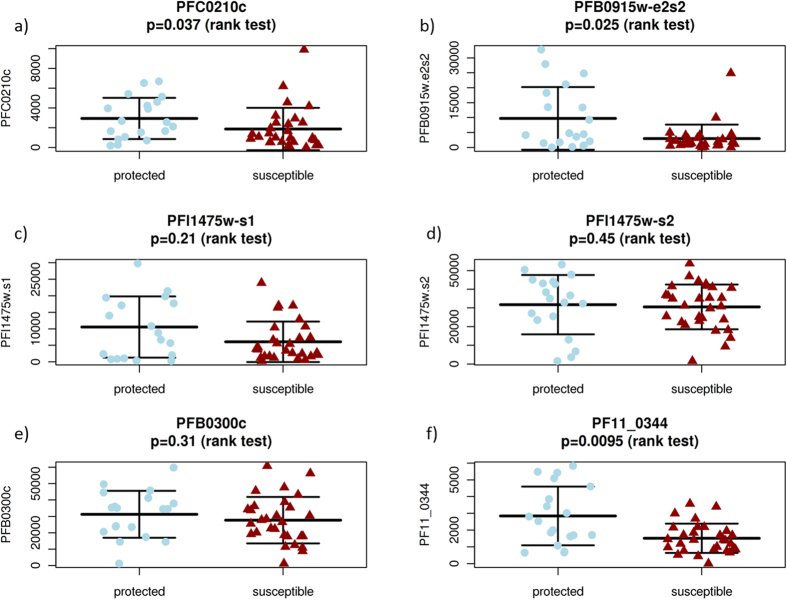
Antibody response against the leading malaria vaccine candidates included in the protein microarray in protected and suceptible children.Antibody reactivity against circumsporozoite protein (CSP, PFC0210c) (a), liver stage antigen 3 (LSA3, PFB0915w) (b), merozoite surface protein 1 (MSP-1, PFI1475w) (c,d), MSP-2 (PFB0300c) (e) and apical membrane antigen 1 (AMA-1, PF11_0344), did not discriminate between protected and susceptible children (FDR > 0.05). P-value from rank test is shown.